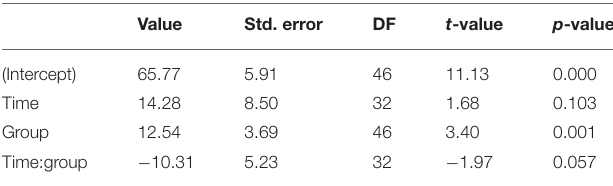
TABLE 3 | Output of mixed effects model using nlme package in